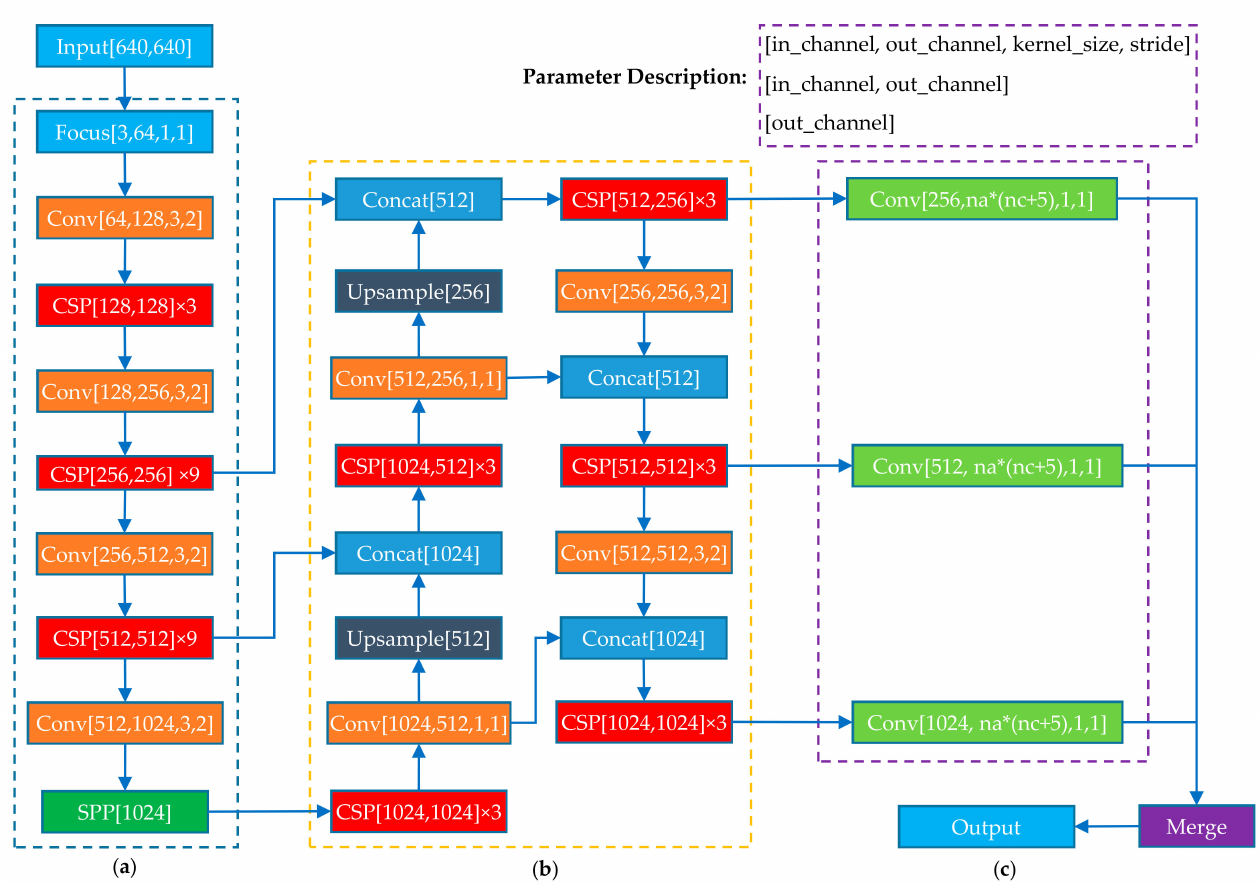
Figure 17. YOLO5s structure. ( a ) The backbone; ( a ) the neck; ( c ) the output. The network structure of YOLOv5s consists of three parts: backbone, neck and head. The backbone, CSPDarknet [45], can effectively extract feature information from the input image through multiple down-sampling. The neck is responsible for aggregating the image features extracted by the backbone with the cascade structure of FPN and bottom-up PANET. The head contains three output branches, which predict the bounding boxes and categories of objects of different sizes. The input image is divided into an S × S grid. For each grid cell, YOLOv5s predicts B bounding boxes. Each bounding box includes 3 categories of parameters, they are the position ( x , y , w , h ) corresponding to (center coordinate ( x , y ), width , height ) of a bounding box, object confidence C and prediction probabilities P of N classes. Therefore, the loss function is composed of bounding box position loss, object confidence loss and class probability loss, as expressed in Equation (28). The bounding